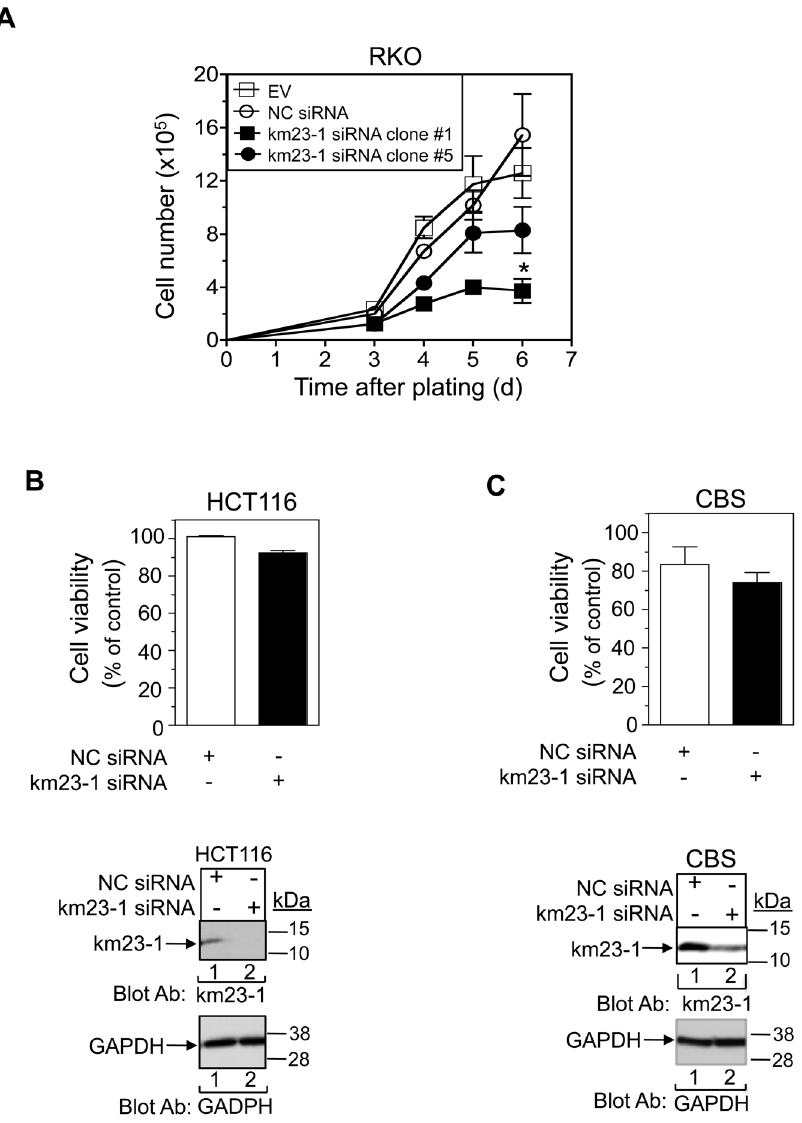
Figure 6. km23-1 silencing inhibits the growth of RKO cells, but not of HCT116 and CBS cells. A: RKO cell clones stably expressing EV, NC siRNA, or km23-1 siRNA [35] were plated and analyzed for cell number by trypan blue exclusion staining over the indicated days after plating. Mean 6 SE (n=3), *p , 0.05 compared to the NC siRNA on day 6. B: Top , HCT116 human CRC cells stably transduced with either pilenti NC siRNA-GFP or pilenti km23-1 siRNA-GFP pools were subjected to XTT assays as described in ‘‘Materials and Methods.’’ Mean 6 SE (n=3). Bottom , HCT116 stable pools were grown and harvested for Western blotting to detect endogenous km23-1. GAPDH expression was used as a loading control. C: Top , similar XTT assays were performed in CBS cells stably transduced with either pilenti NC siRNA-GFP or pilenti km23-1 siRNA-GFP pools. Bottom , CBS stable pools were analyzed by Western blotting as for the bottom panel of B .